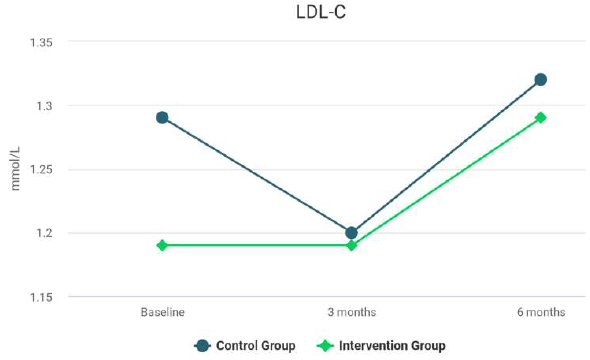
Figure 3. Results of LDL-C at baseline and during follow-up.